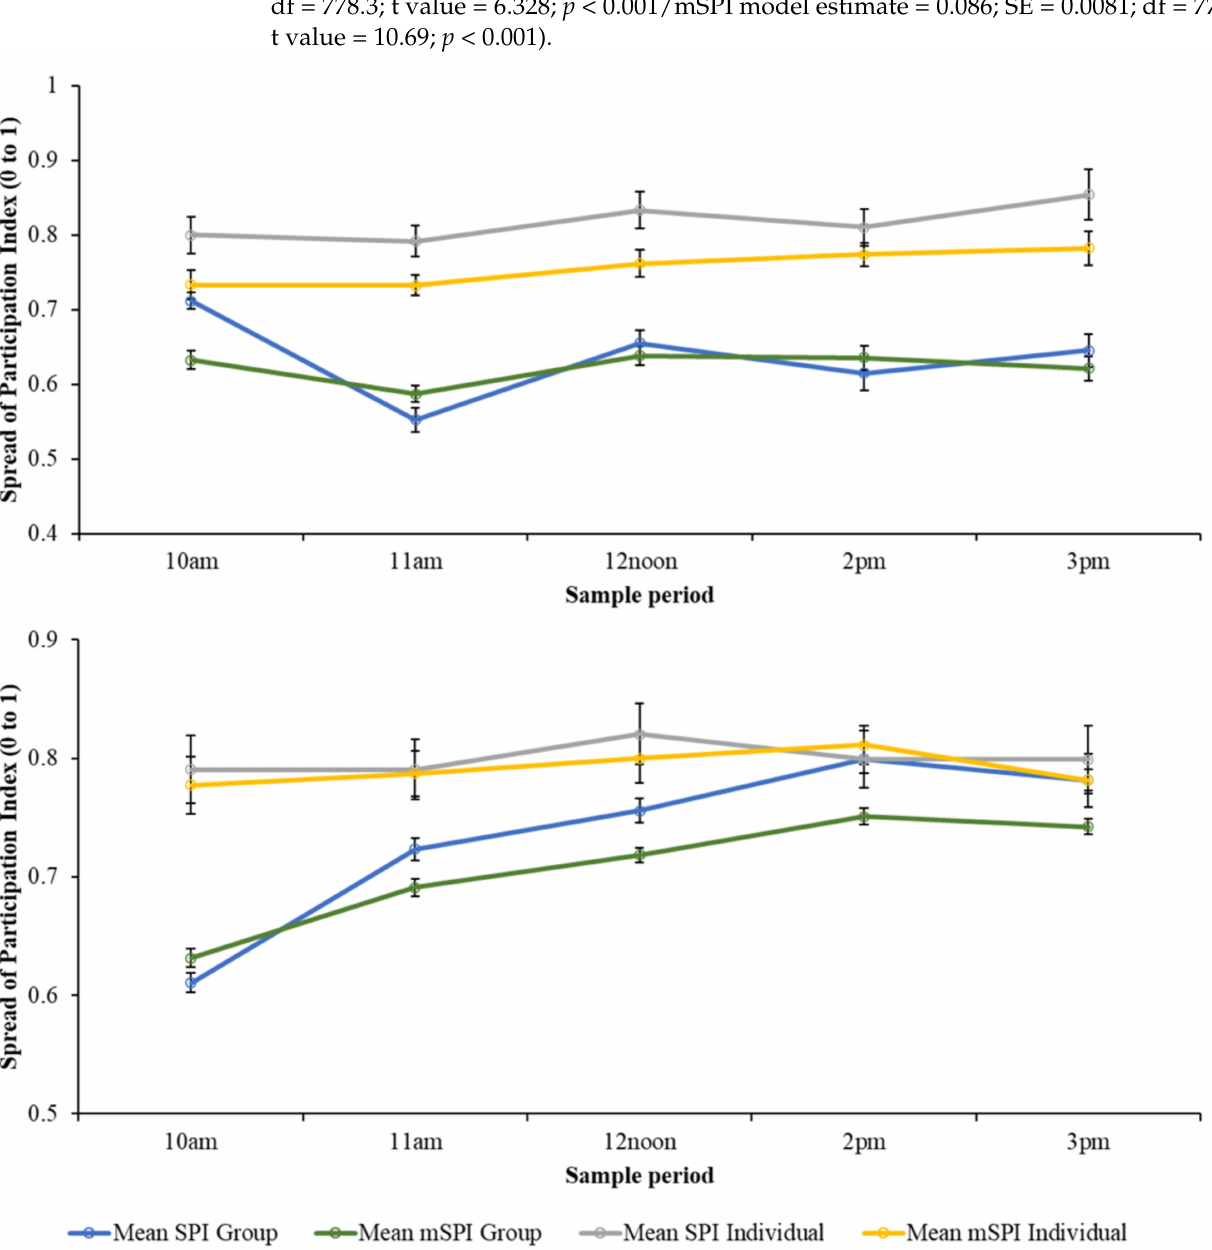
Figure 2. Relationship between daily mean indices (+/ − SE) for group data and individual bird data when calculated using the traditional and modified SPI equations. PZ flamingos ( top ) and BZ flamingos ( bottom ). When applied to group data, both the SPI and mSPI suggest a wider range of enclosure zone occupancy, although this is highly influenced by time of